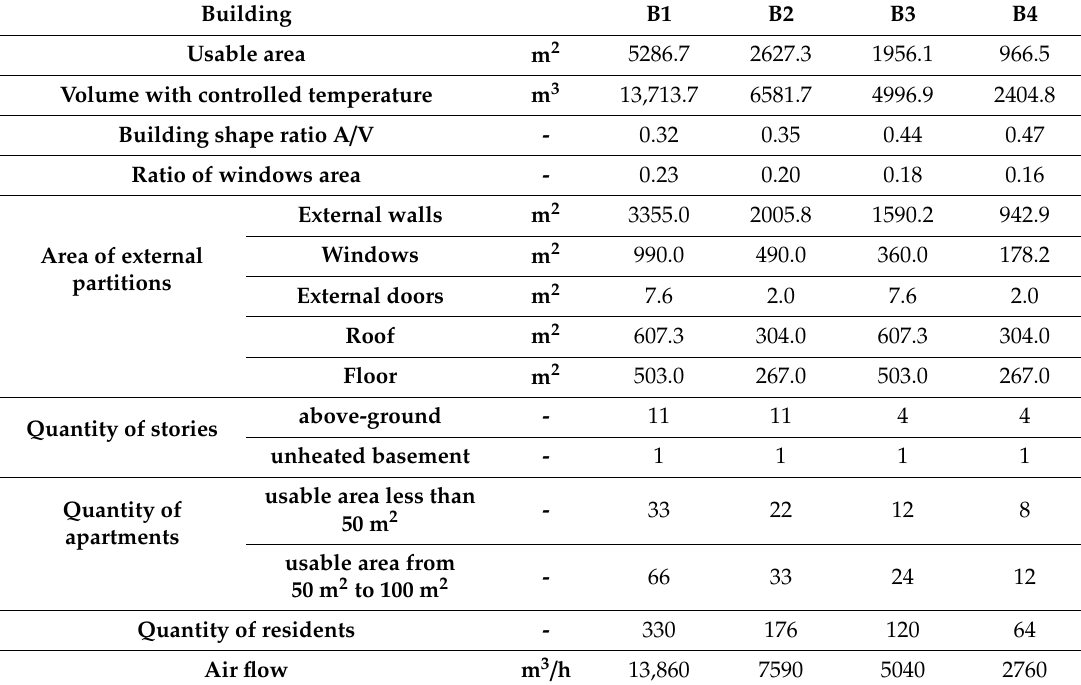
Table 4. General multi-family residential building information.